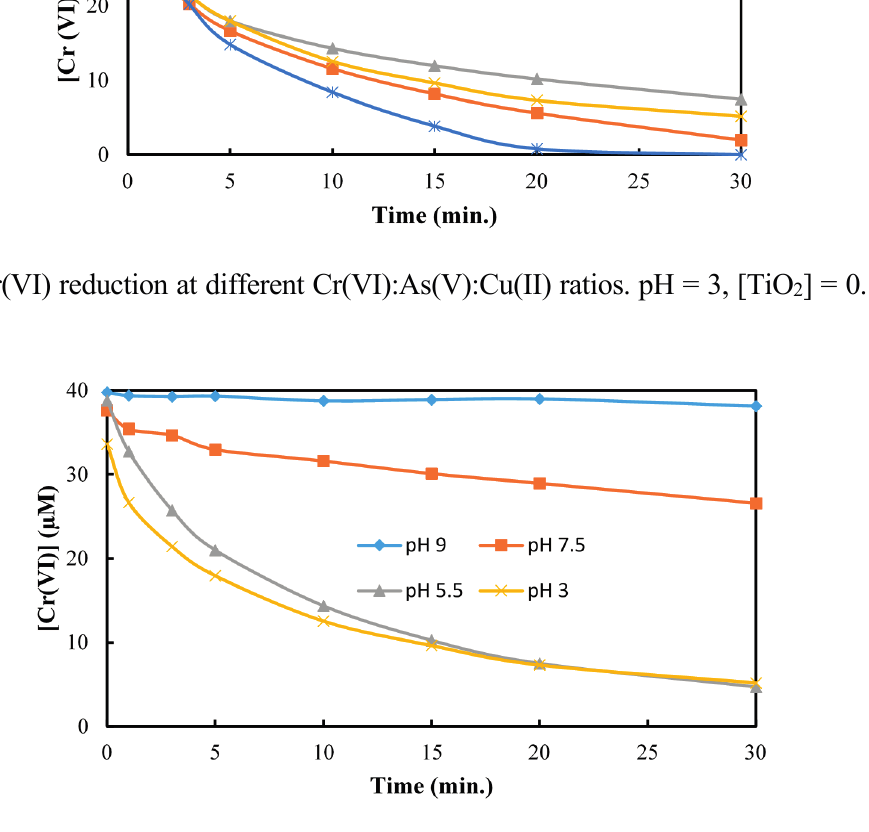
Figure 10. The pH effect on Cr(VI) reduction in presence of As (V) and Cu (II). Cr(VI):As(V):Cu(II) = 1.6:1:1. [TiO 2 ] = 0.10 g/L, 350